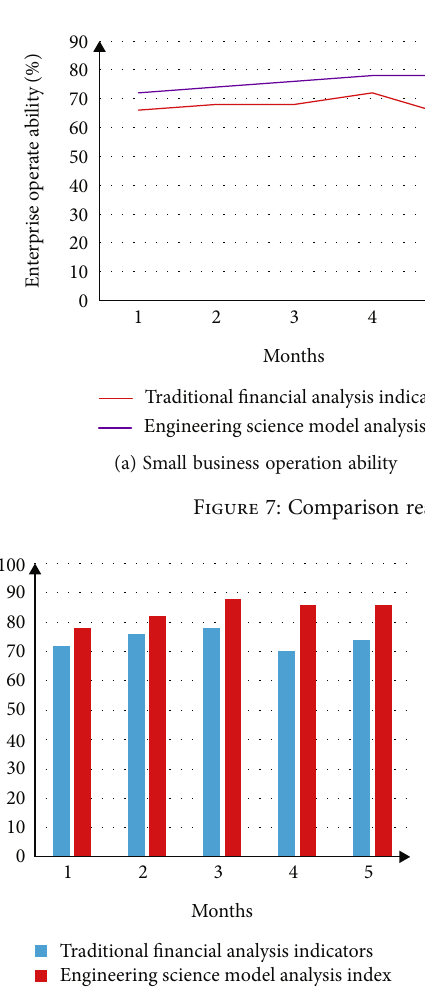
Figure 8: The comparison result of the accuracy of fi nancial information analysis.